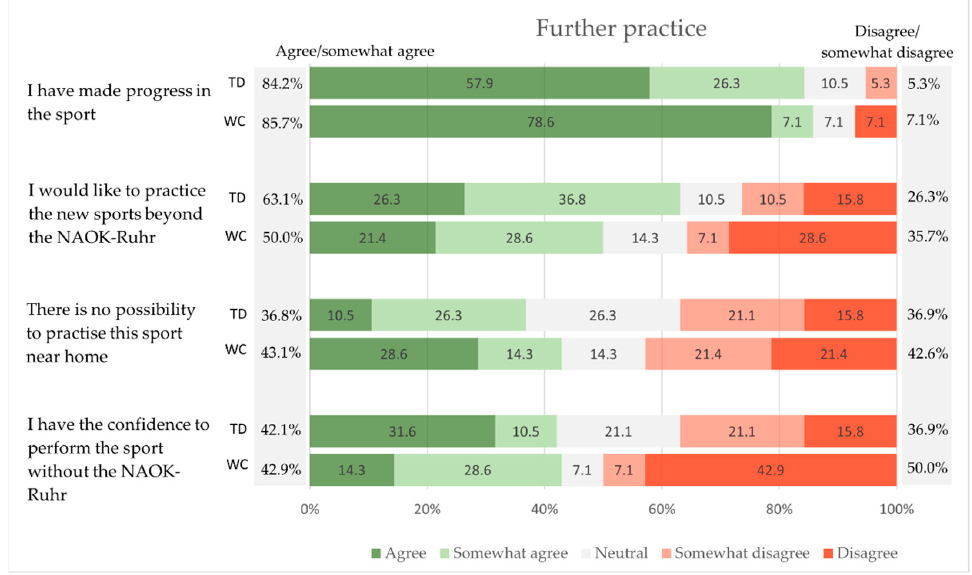
Figure 5. Further practice of the new sports (TD = try-out day, WC = weekend camp).